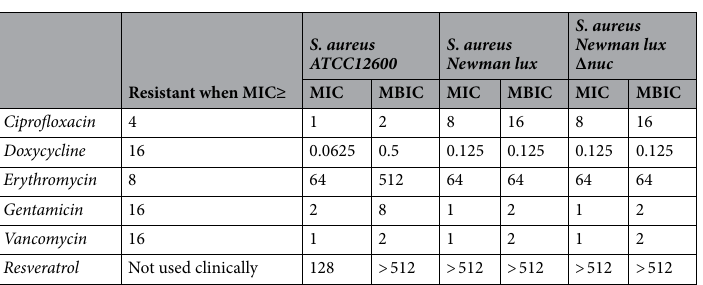
Table 2. Resistance cutoff points 31 , minimal inhibitory concentrations (MIC) and minimal biofilm inhibitory concentrations (MBIC) (µg/ml) of antimicrobials for Staphylococcus aureus ATCC12600, Newman lux, and Newman lux Δnuc1 strains.